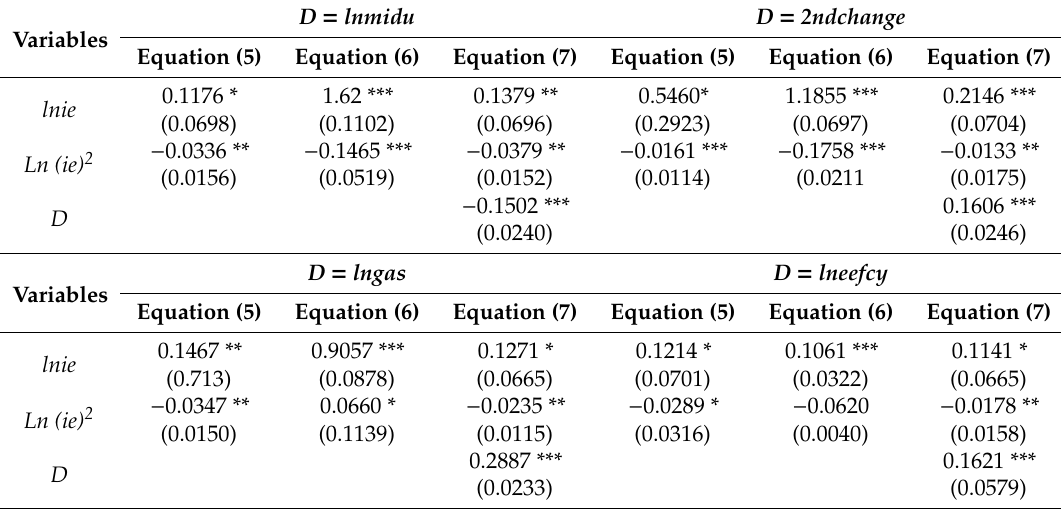
Table 8. Mediating e ff ect